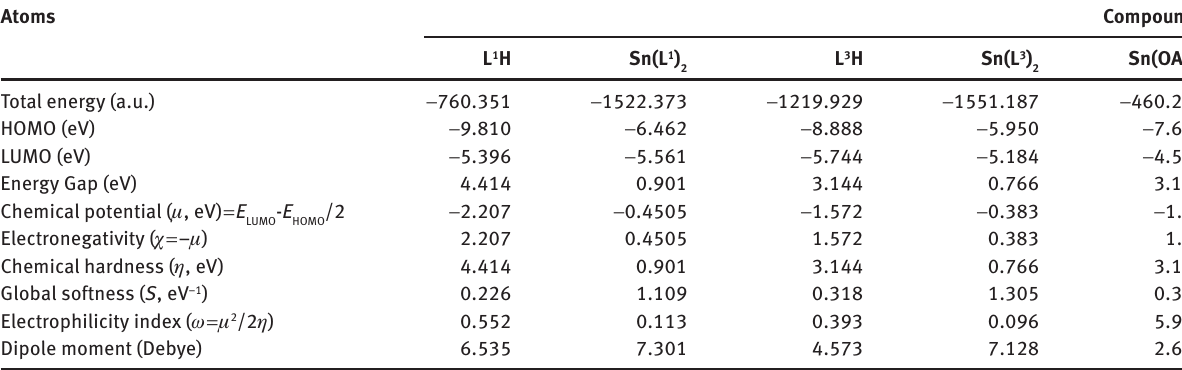
Table 6: Computed molecular descriptions of ligands L 1 H, L 3 H and their tin(II) complexes. Atoms Compounds